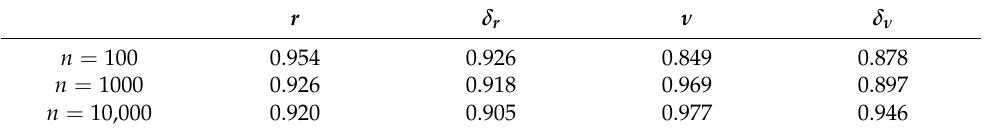
Table 5. Proportions of true parameter values falling into asymptotic confidence intervals for 1000 runs for the sample size n with true parameter values r = 0.4, ν = 1.7, s = 0.7, t = 1.5, δ = 1.